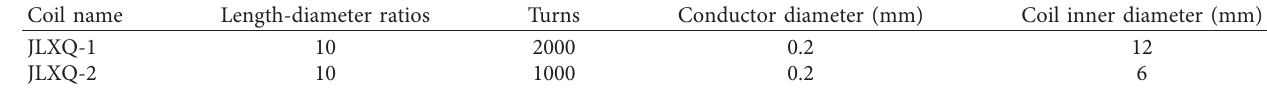
Table 1: Technical parameters of the exciting